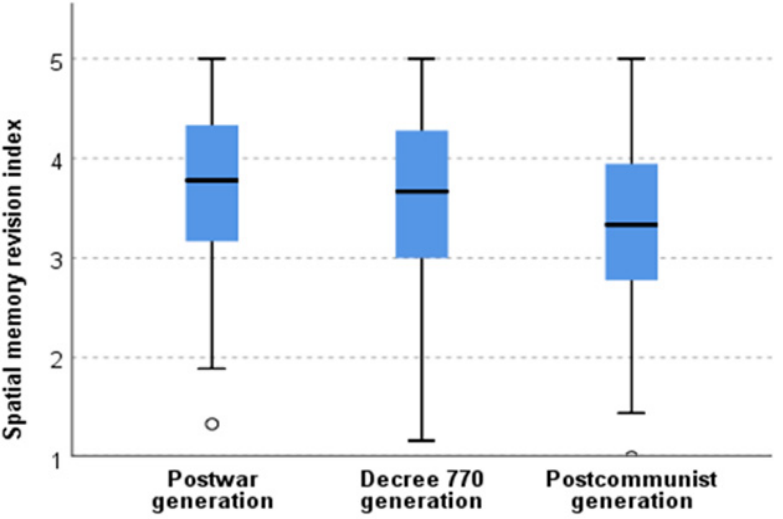
Figure 1. Intergeneration differences towards the revision of the spatial memory during postcommunist Romania.